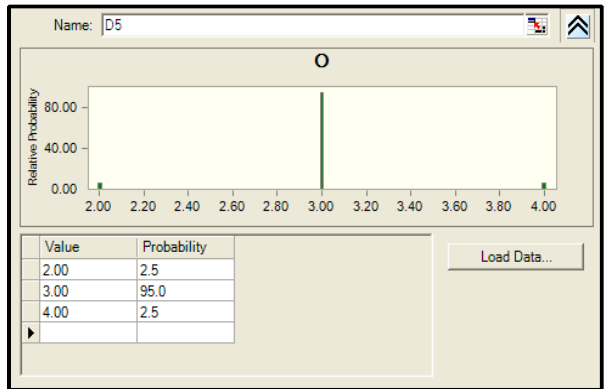
Figure 10. Case 1: Discrete nonuniform distribution of O in CB software.